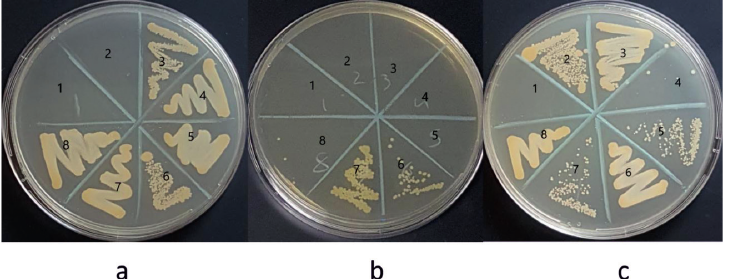
Fig. 6. S. sciuri MBC, (a) Sodium hypochlorite #2 = 10000 µg/ml, (b) Benzalkonium chloride #5 = 8.6 µg/ml and (c) Chloroxylenol #1 = 300